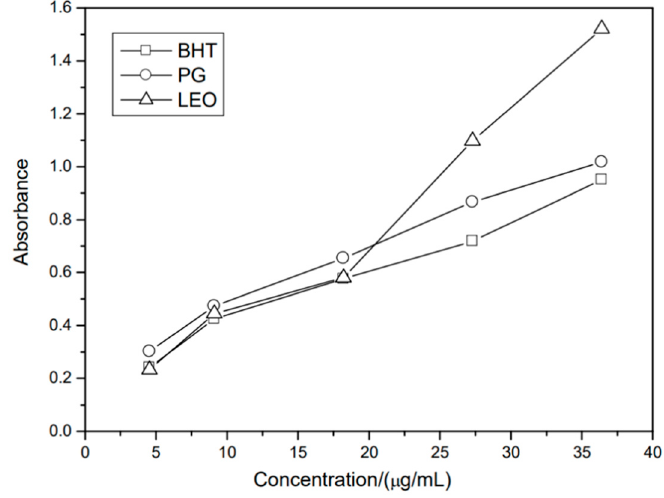
Figure 23. Absorbance of antioxidants in different concentrations of 2,6-ditert-butylphenol (BHT, square), propyl gallate (PG, circle) and Laurus nobilis essential oil (LEO, triangle) [207].